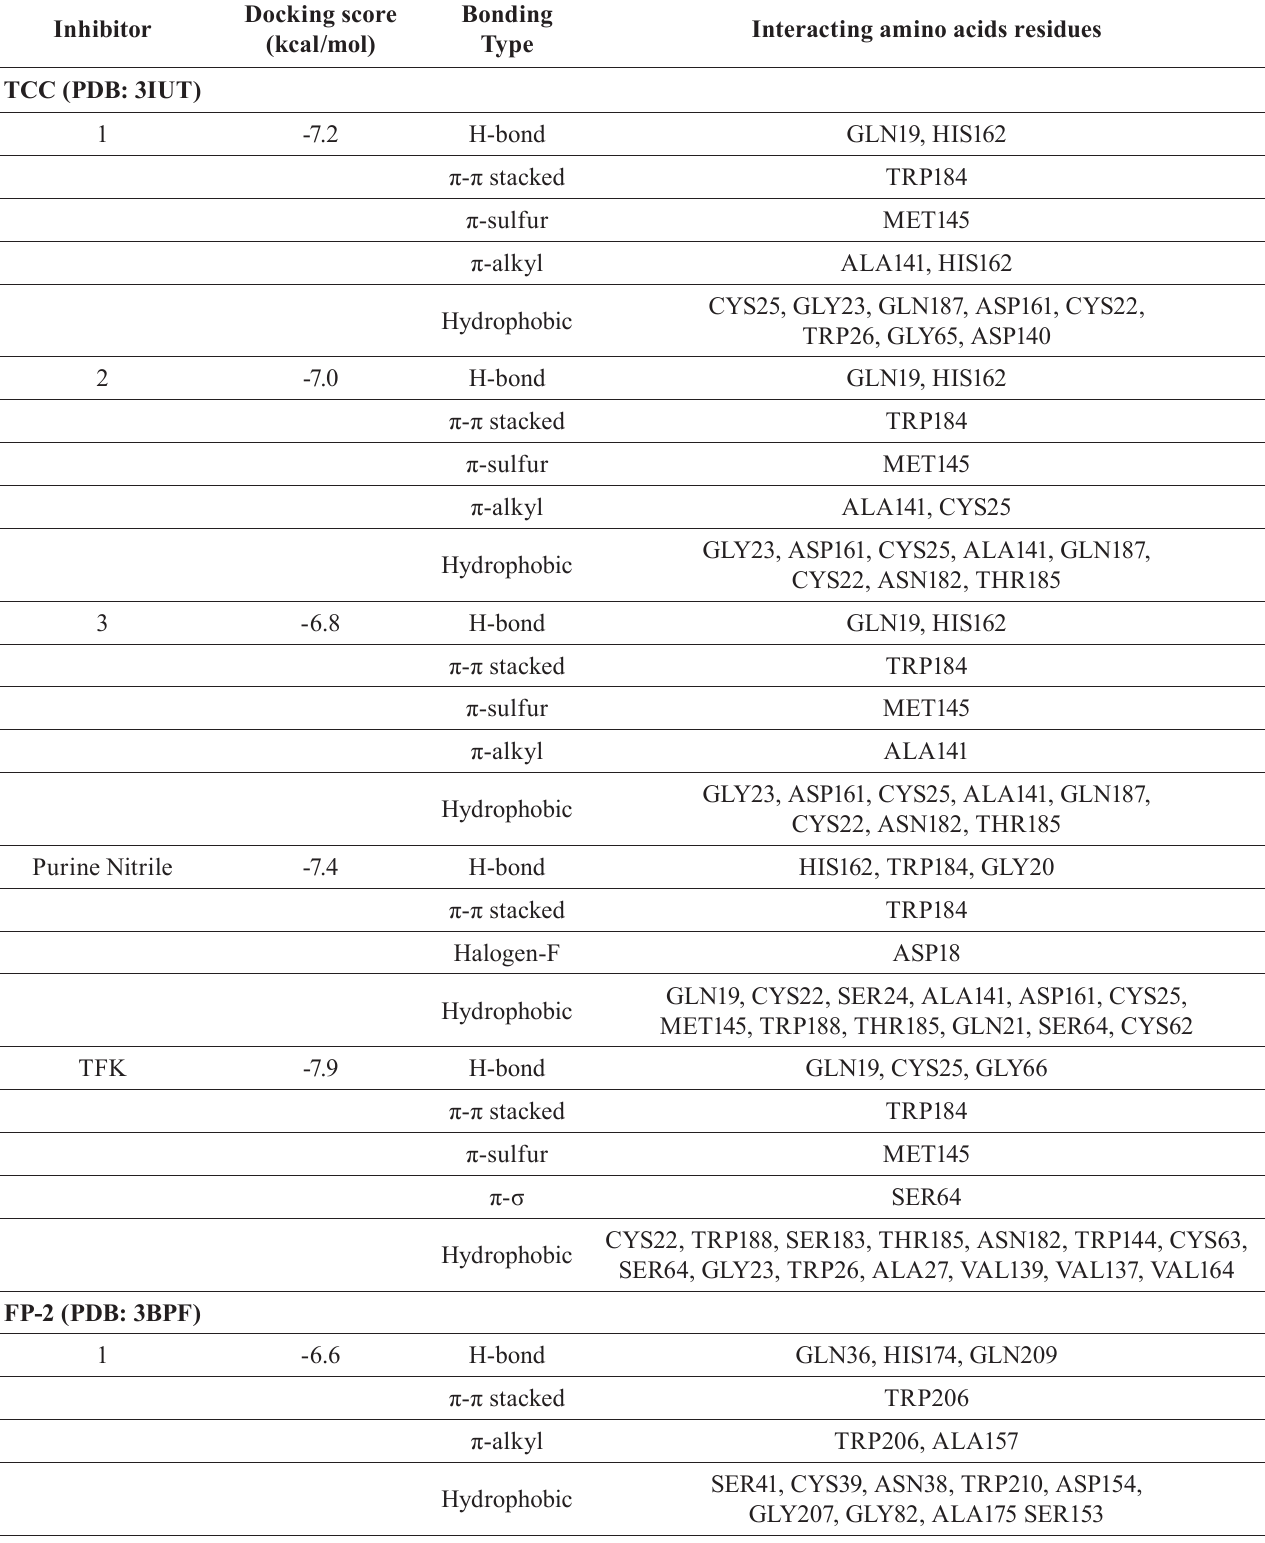
TABLE III - Best binding energy (kcal/mol) based on AutoDock scoring of the hybrids into the active sites of the